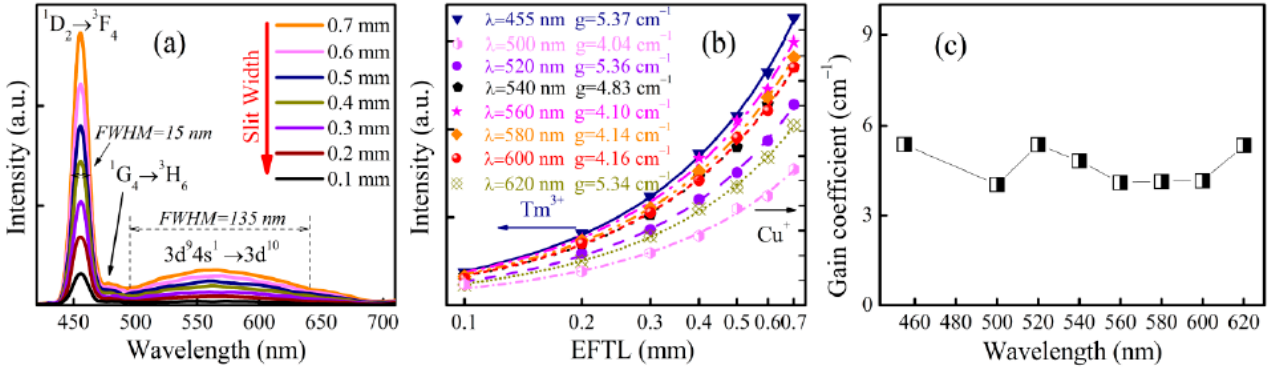
Figure 4. ( a ) Emission spectra of GC0.40T0.25 glass under the excitation of 365 nm when the EFTL is changed from 0.1 to 0.7 mm; ( b ) Dependences of emission intensity for Tm 3+ and Cu + on the wavelength and EFTL; ( c ) Relationship between NOGC and